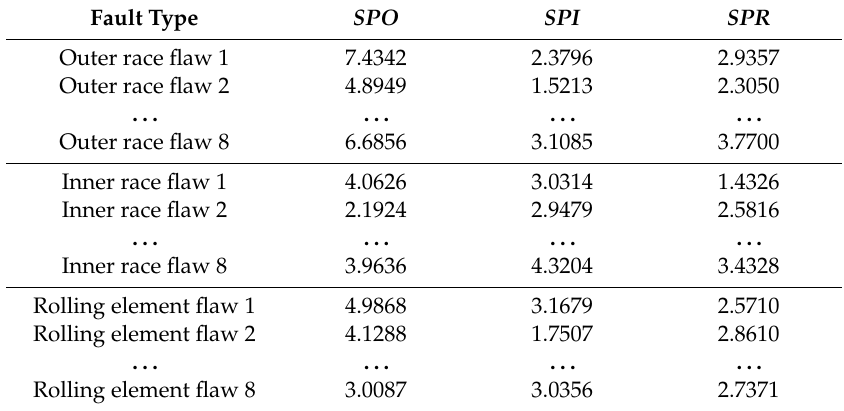
Table 3. The dedicated symptom parameters for bearing fault isolation of CH3 (learning